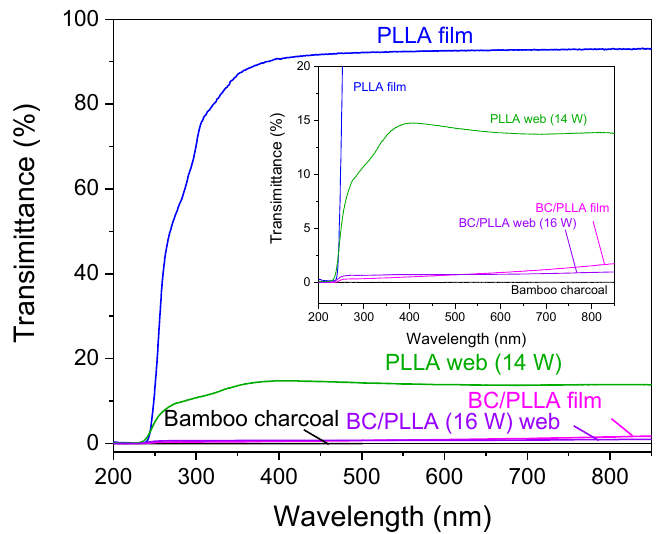
Figure 16. Ultraviolet–visible transmission spectra of PLLA and BC/PLLA films and electrospun PLLA (14 W) and BC/PLLA (16 W) webs.